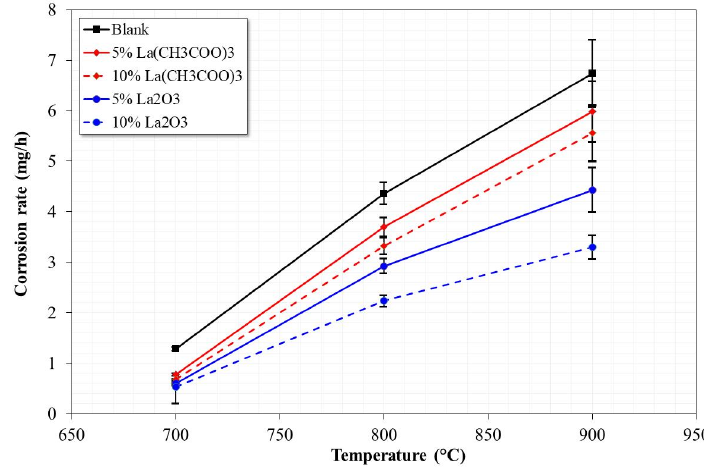
Figure 1. Corrosion rate for 304H steel after 100 h of testing in NaVO 3 with and without the addition of La-base inhibitor at 700, 800, and 900 °C.